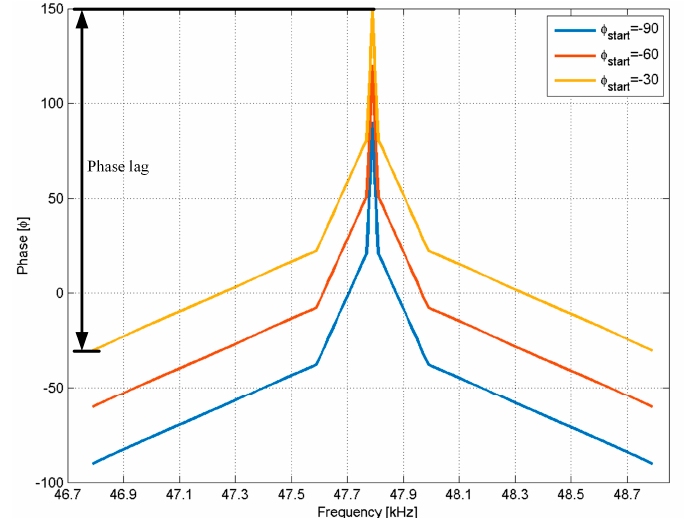
Figure 4. Phase difference between the stimulating voltage at the integrated piezoelectric layer and the supply voltage at the